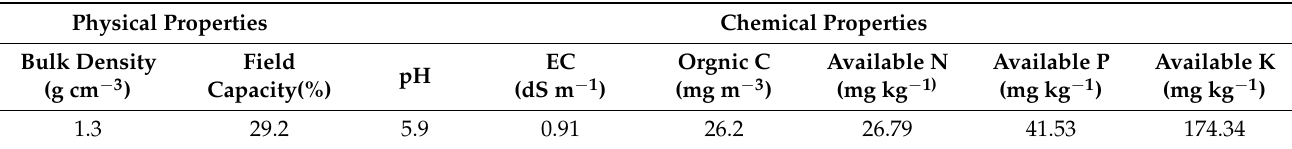
Table 1. Physical and chemical properties of the soil at the experiment location.